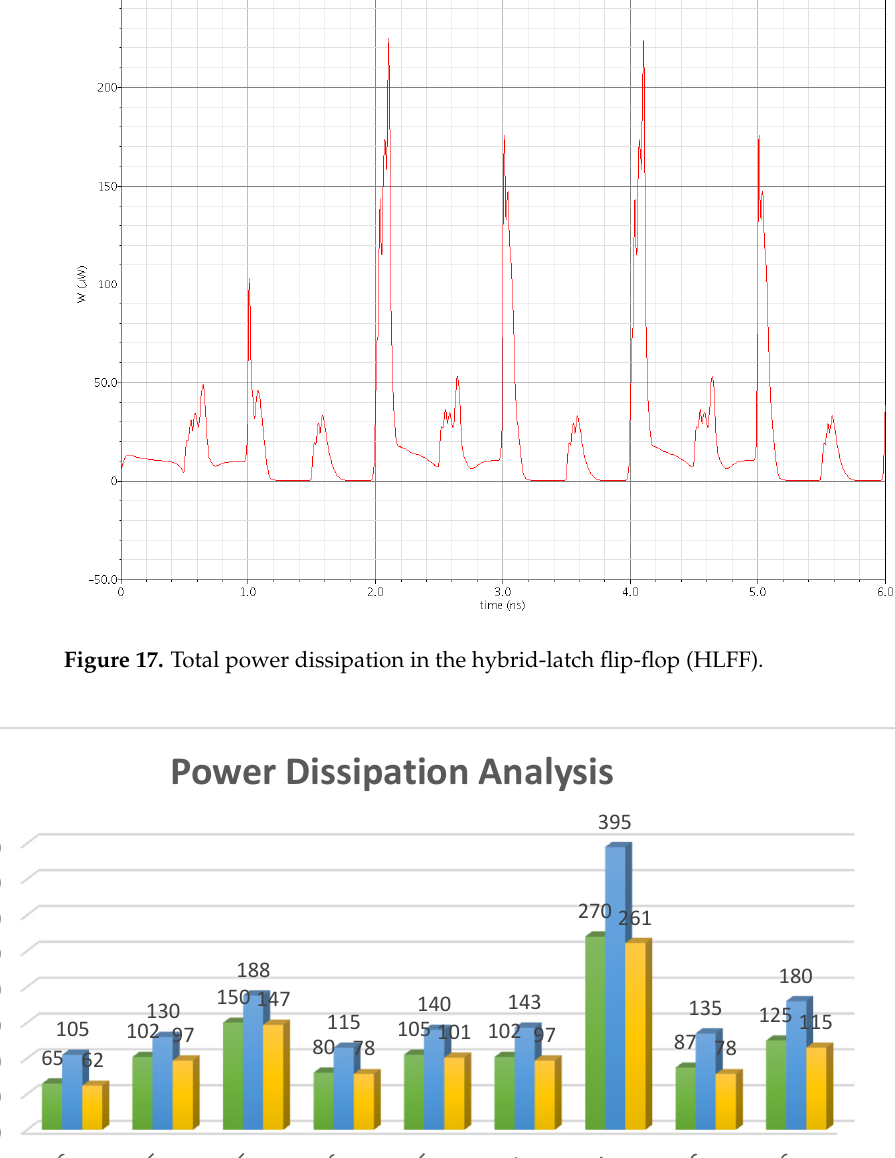
Figure 18. Total power dissipation analysis using 65 nm process technology and various types of input signals.